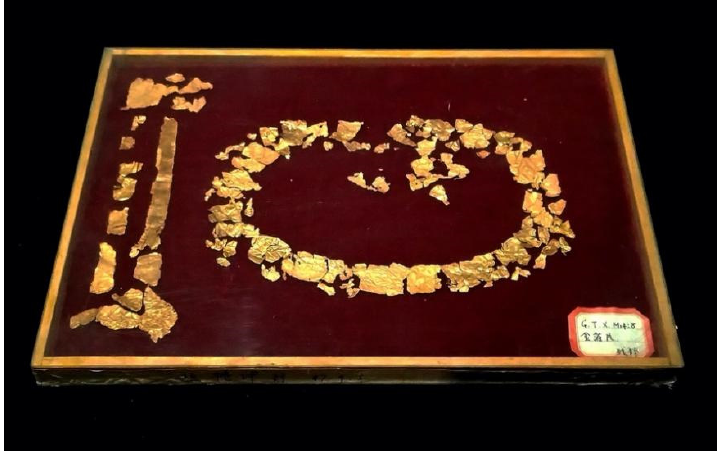
Figure 7. Gold Leaf from the Middle Shang Dynasty. Materials: gold. Dimensions: T. 1mm. Displayed in the Hebei Provincial Institute of Cultural Heritage and Archaeology, China. Photograph taken by the author.